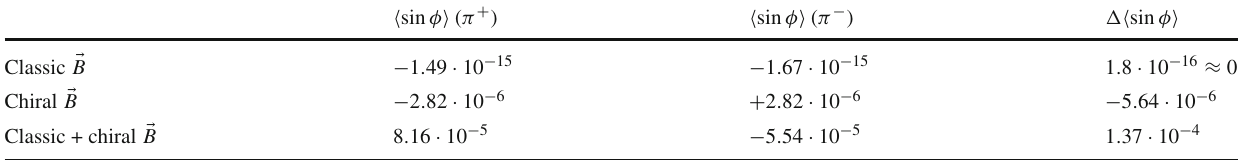
Table 2 First two columns: (cid:2) sin φ (cid:3) at | y | (cid:8) 0 for positive and neg- tations the electric charge density was computed by using the vorticity ative pions, third column: (cid:7) (cid:2) sin φ (cid:3) = (cid:2) sin φ (cid:3) (π + ) − (cid:2) sin φ (cid:3) (π − ) . method (App. G2). When including an initial magnetic field with a con- The results refer to numerical simulations of Au+Au collisions at √ tribution from chiral charges, the results turn from a roughly null value s NN = 200GeV with impact parameter b = 8fm. In these compu- (first row) to a non zero signal (second row) (cid:2) sin φ (cid:3) (π + ) (cid:2) sin φ (cid:3) (π − ) (cid:7) (cid:2) sin φ